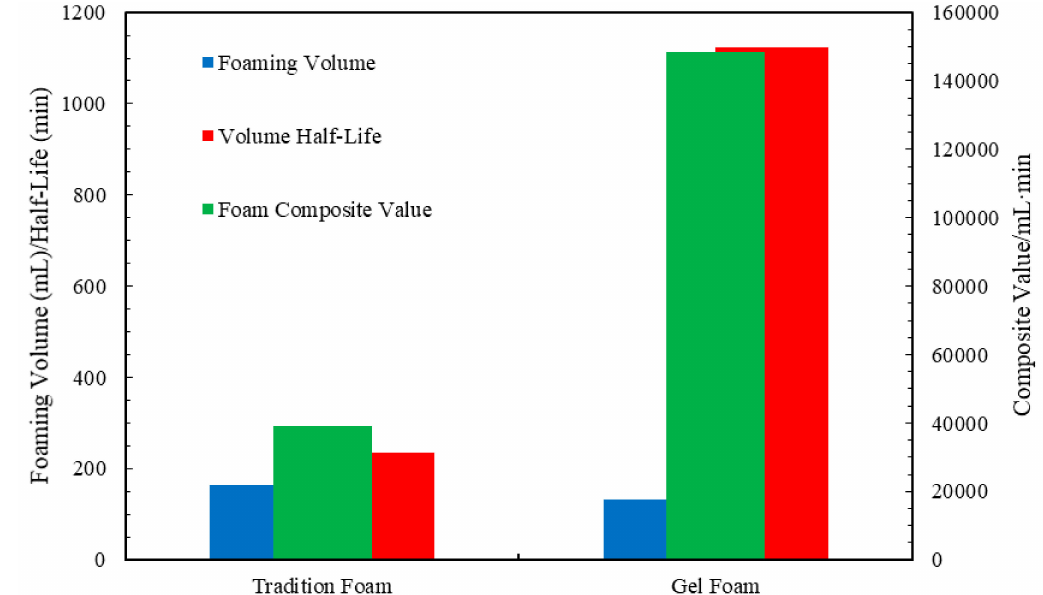
Figure 7. Effects of different gel formulas on the foam’s